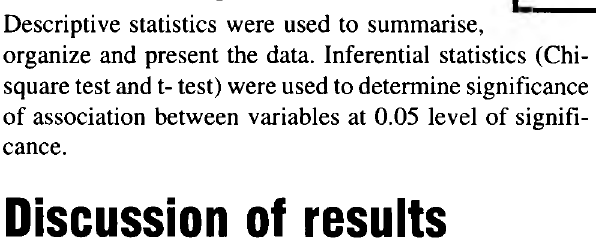
Table 3: Hand decontamination following patient contact